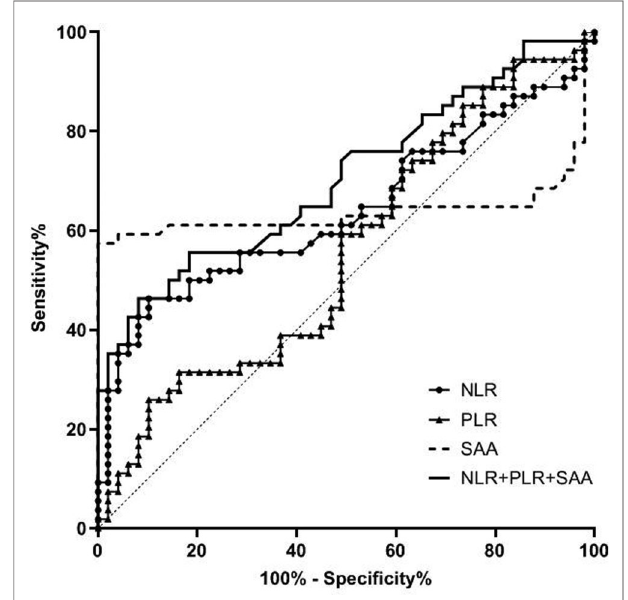
FIGURE 3 | Value of serum NLR, PLR and SAA levels in predicting patients with stage III CRC.